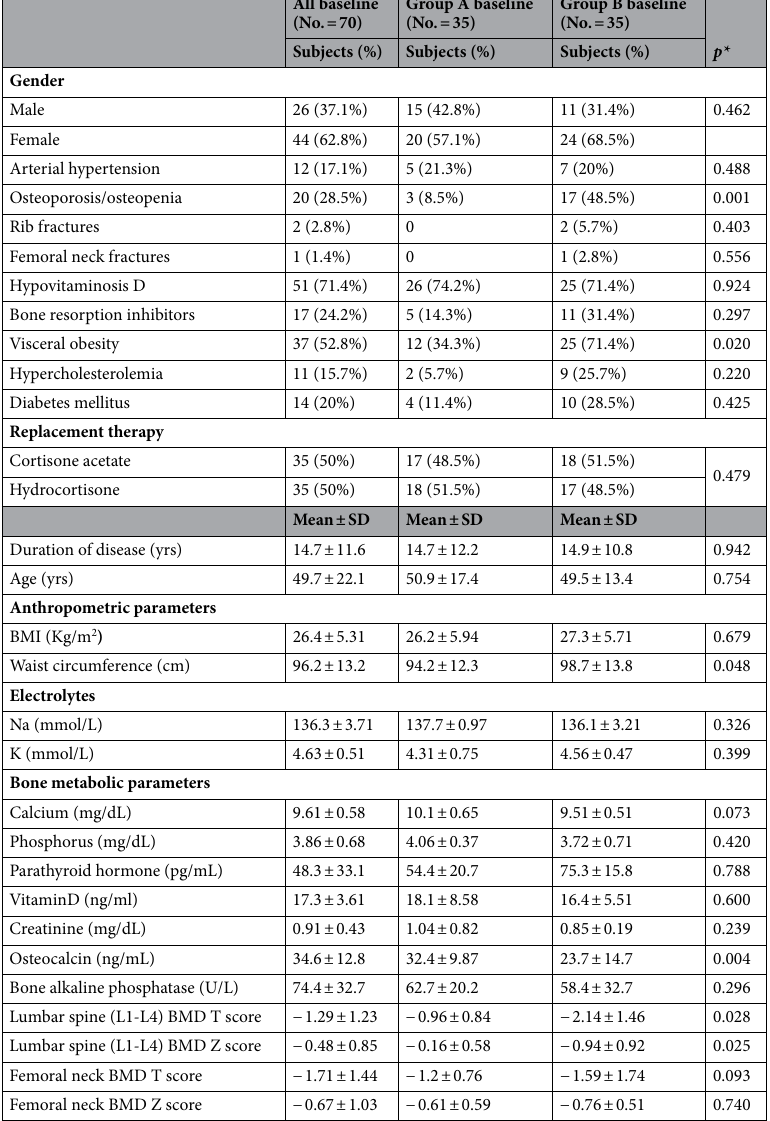
Table 2. General characteristics of all patients and subgroups A and B at baseline. * p value between patients in group A and B at